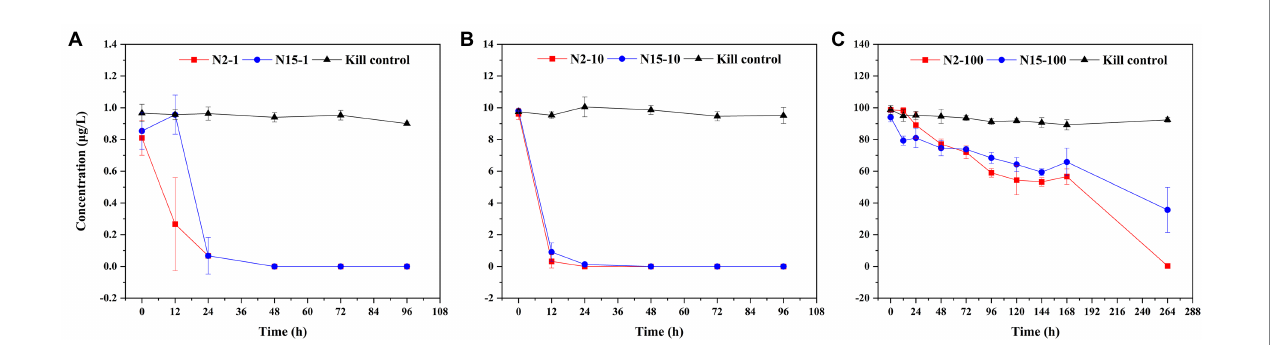
FIGURE 1 Degradation curves of E1 in sample water from sites N2 and N15 with different concentrations: (A) E1 with a concentration of 1 μ g/l; (B) E1 with a concentration of 10 μ g/l; (C) E1 with a concentration of 100 μ g/l. The red square represents a sample from site N2; the blue circle represents a sample from site N15; the black triangle represents the kill